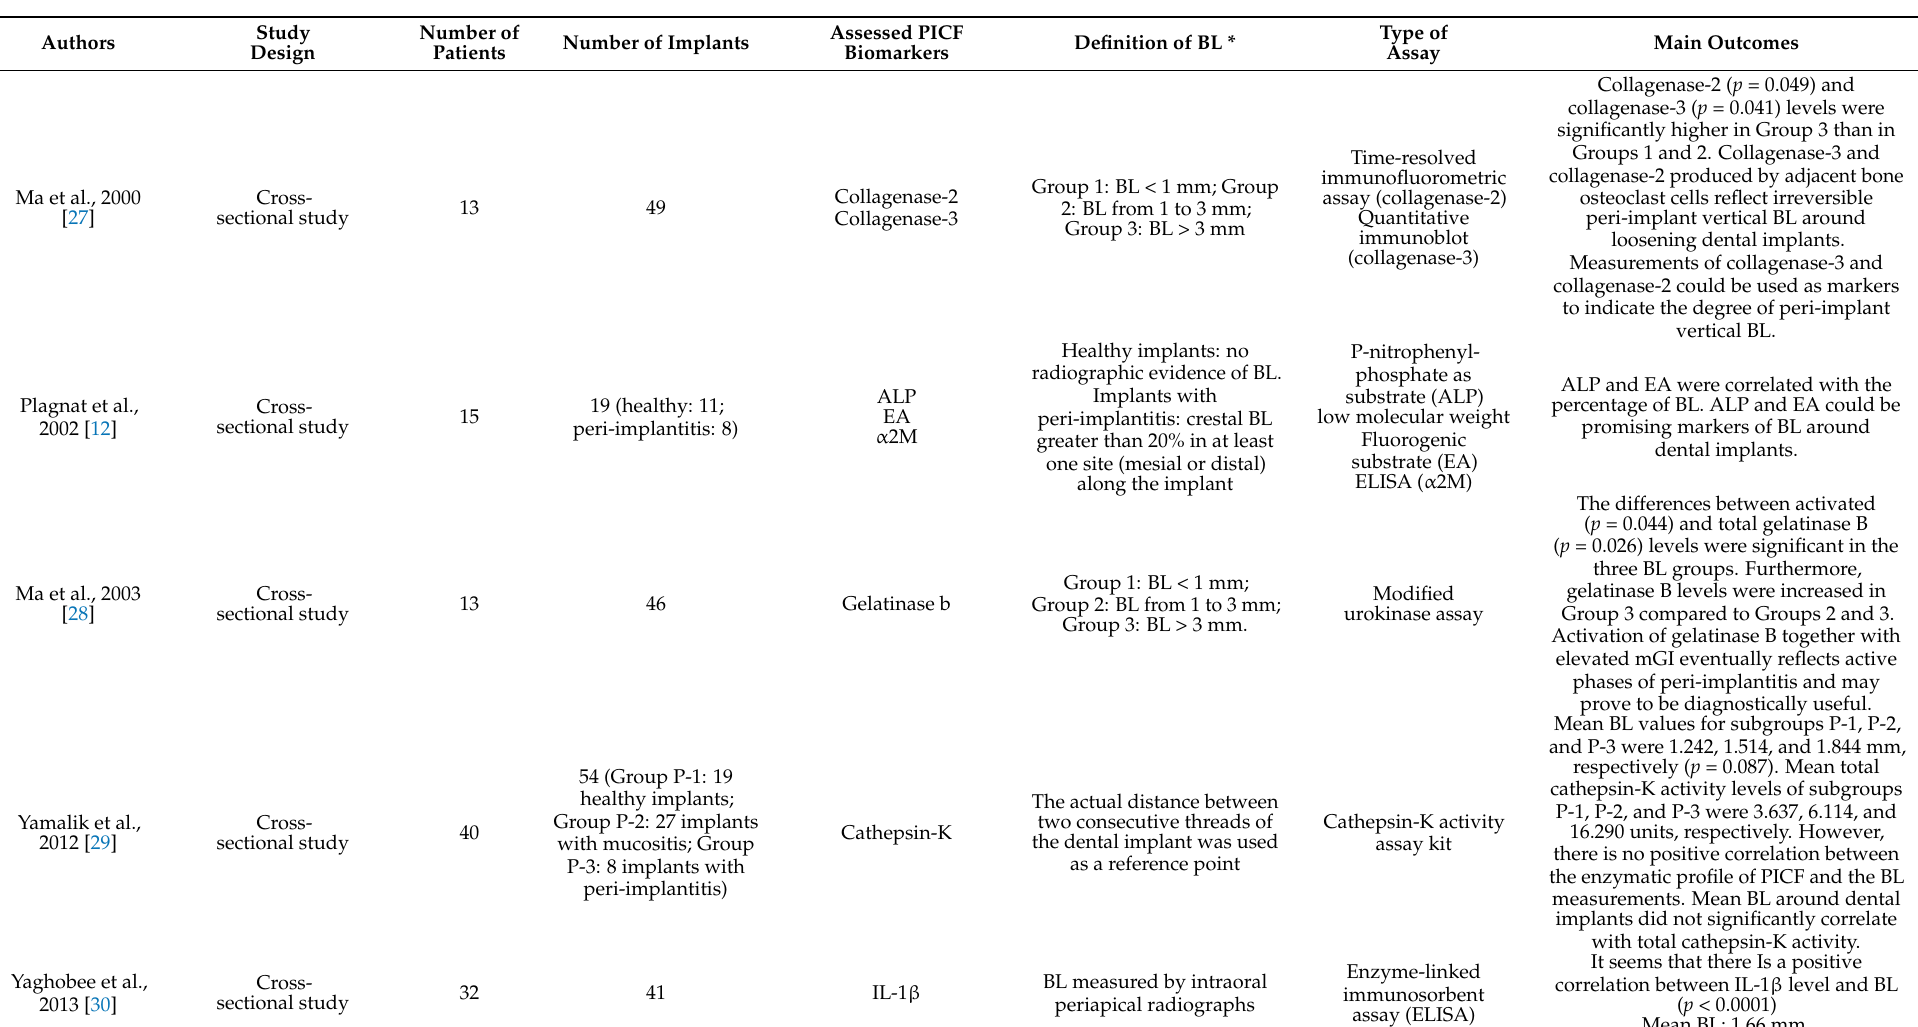
Table 1. Main characteristics of included